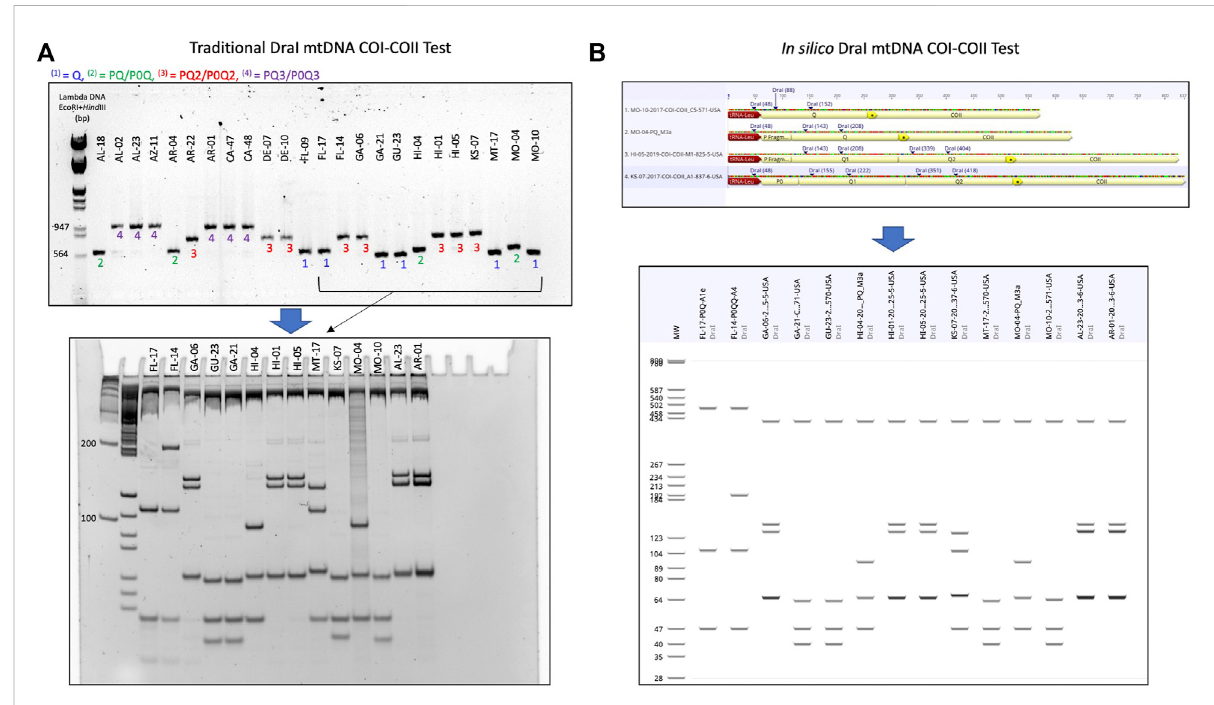
FIGURE 2 Procedure detailing the transition from the traditional DraI mtDNA COI-COII (DmCC) test to the in silico DmCC test. (A) Lineage identi fi cation based on the mtDNA COI-COII length revealed on 1.5% agarose gel, DraI enzymatic restriction of the PCR products and visual haplotype identi fi cation on 7.5% polyacrylamide gel. (B) Determination of COI-COII genetic structure (Q, PQ, PQ2, P0Q2) by sequence alignment and annotation. In silico DraI restriction of the sequences and haplotype identi fi cation on a virtual gel. The same samples shown in (A) were run in (B)